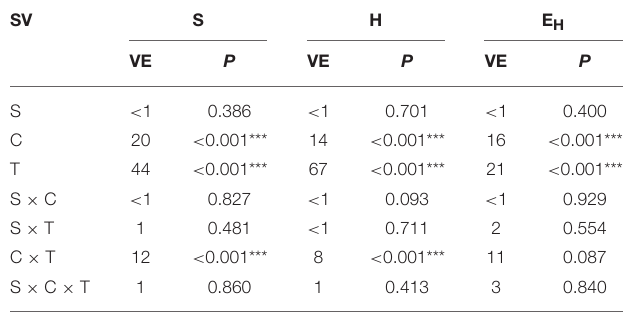
TABLE 2 | Analysis of variance (the three-way ANOVA) for the DGGE indices: richness (S), Shannon-Wiener (H) and evenness (E H ) as affected by the bacterial strain (S), concentration (C), time (T) and their